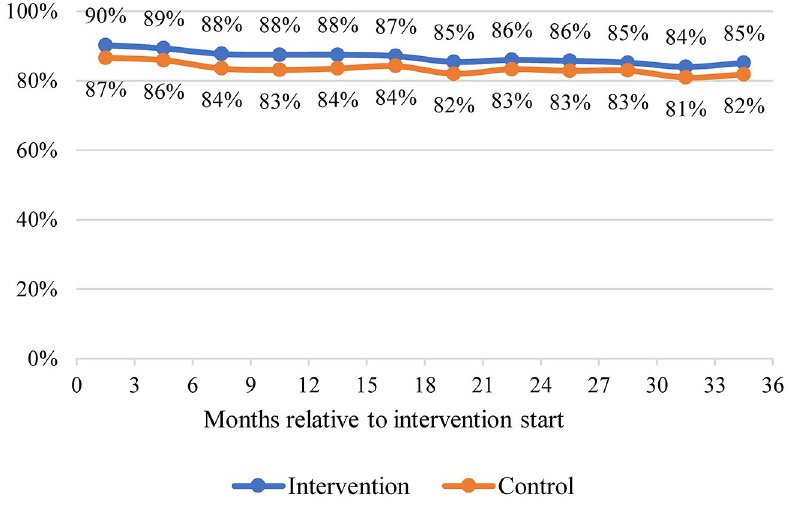
Fig 2. Adherence to booked quarterly consultations. Adherence to booked consultations is calculated as the proportion of patients in each arm who responded to their quarterly (i.e., every 3 months) follow-up clinical consultations with health workers within each 3-month follow-up period. A mixed-effects logistic regression analysis of patients’ adherence (yes/no) to their final quarterly booked consultation—with fixed effects for treatment arm, patient age, sex, body mass index, occupation (farmer or non-farmer), educational level (primary school or below, or high school or above), marital status (married or non-married), income (less than 10,000 RMB or 10,000 RMB or above), and diagnosis (hypertension without type 2 diabetes, type 2 diabetes without hypertension, hypertension with type 2 diabetes), and a random intercept for cluster—demonstrated no significant difference between treatment arms (intervention versus control adjusted odds ratio = 1.44 [95% CI: 0.88, 2.36; P = 0.144]). This analysis excluded 1,112 (8.3%) and 1,432 (9.7%) patients from the intention-to-treat population intervention ( n = 13,385) and control ( n = 14,745) arms, respectively, due to missing covariate or outcome